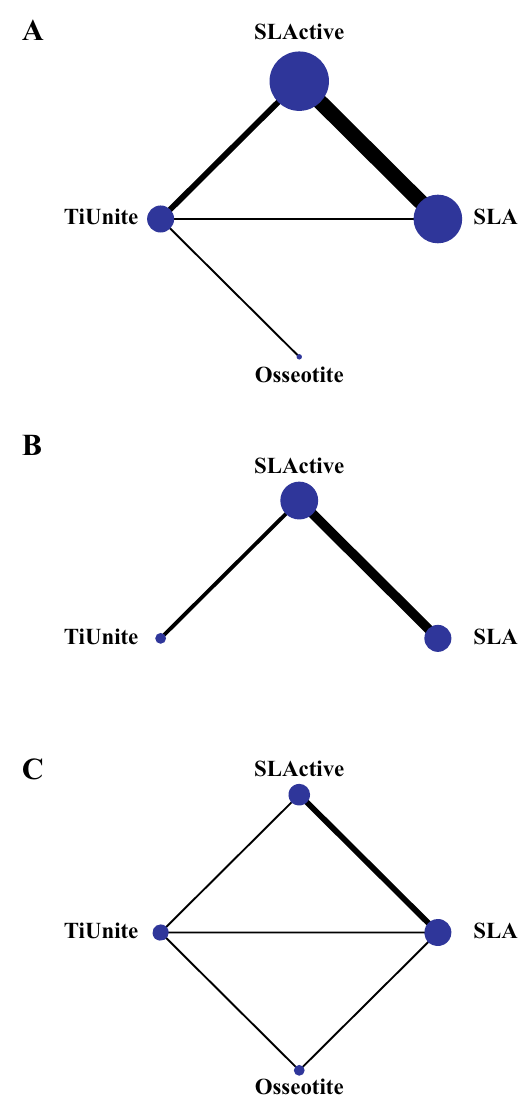
Figure 2. Network plot of comparisons. ( A ) BIC value of final healing stage; ( B ) BIC value of early healing stage; ( C ) ISQ value of final healing stage. The width of the lines is proportional to the number of trials directly comparing each pair of treatments. The size of each node is proportional to the number of studies for each